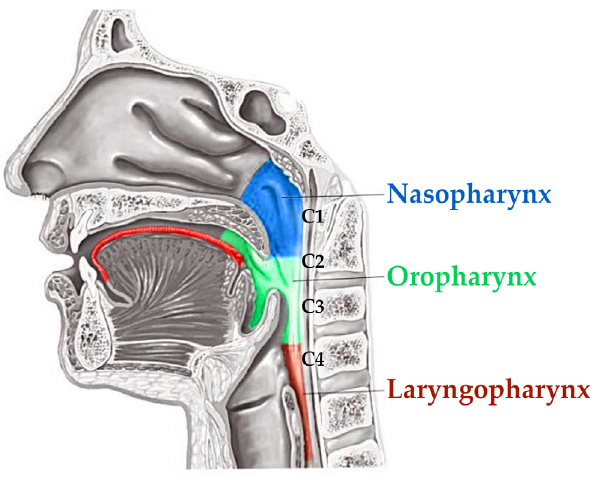
Figure 1. Schematic drawing of tongue position in the oral cavity and oropharynx portion of the pharynx where the airway changes after aligner therapy was evaluated.